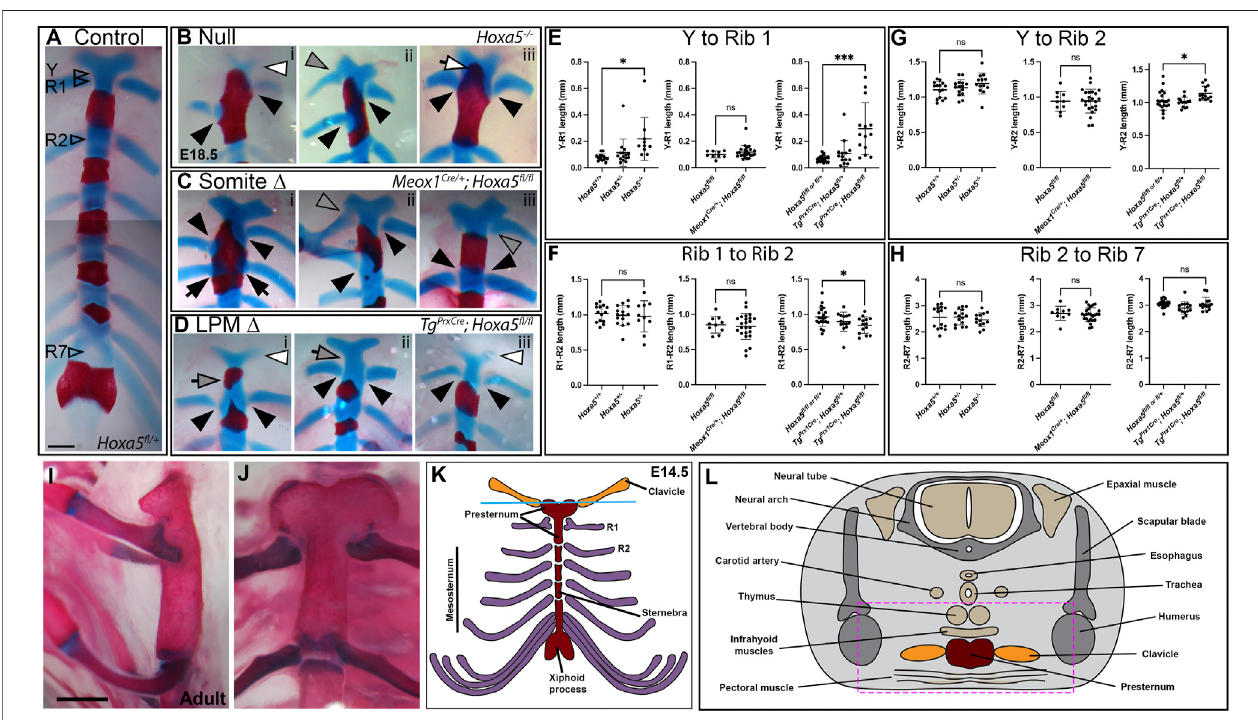
FIGURE 3 | Sternum phenotypes associated with conditional Hoxa5 deletion at E18.5. (A) Control sternum at E18.5. Arrowheads indicate the positions at which measurements were taken for data shown in panels (E – H) . (B – D) Examples of anterior sternum phenotypes. In all panels, fi lled black arrowheads indicate T1 ribs, black arrowsindicateT2ribs,andgreyarrowheadsindicateC7ribs.WhitearrowheadsindicateY-shapedcartilagereduction,andwhitearrowin (Biii) indicatesectopicossi fi cation of the Y-shaped cartilage. Grey arrows in (Di,ii) indicate an elongated sternum region between the Y-shaped cartilage and T1 attachment position, which was sometimesassociatedwithanectopicossi fi cation. Scalebar:500 µm. (E – H) Comparativelengths ofsternalregionsbetween arroweads indicatedin (A) . Ineachpanel,null crosses are graphed on the left, somite-speci fi c deletion in the middle and LPM-speci fi c deletion on the right. Bars and brackets indicate the mean and standard deviation, respectively. * p < 0.05, ** p < 0.01, *** p < 0.001, n.s. not signi fi cant, Welch ’ s t -test. (I,J) Adult sternum with T1 and T2 attachments shown in side (I) or front (J) views. (K) Schematic of E14.5 sternum and ribs attachments. (L) Schematic of a cross-sections through an E14.5 embryo at the axial level indicated by the blue line in (K) .